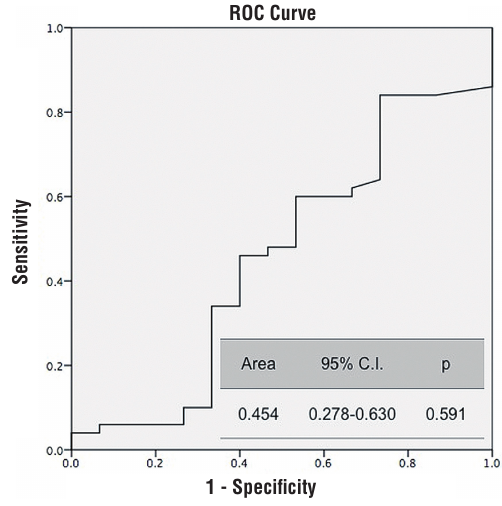
figure 3 - NLR predictive probability of the tumor